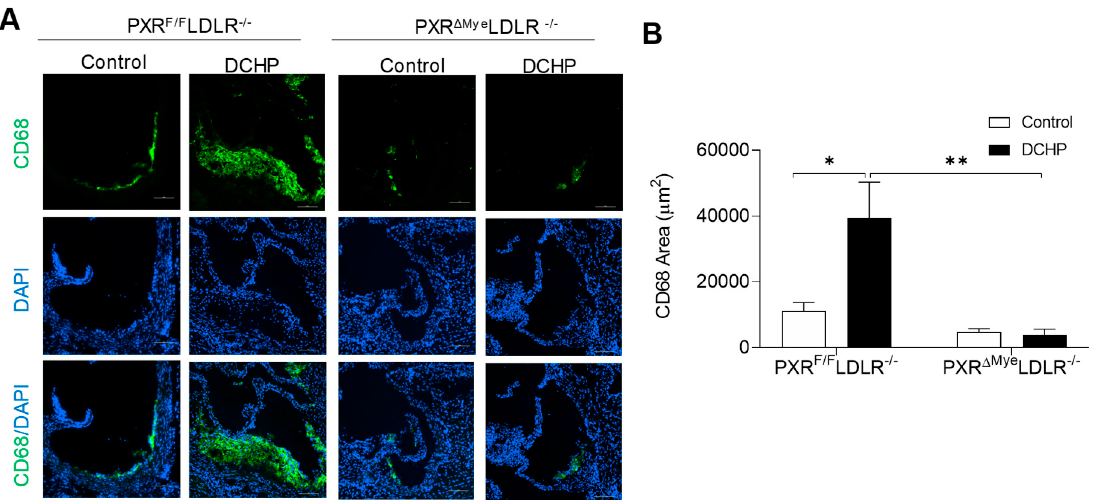
Figure 5. Exposure to DCHP increases atherosclerotic lesional macrophage content in PXR F/F LDLR − / − but not PXR ∆ Mye LDLR − / − mice. Four-week-old male PXR F/F LDLR − / − and PXR ∆ Mye LDLR − / − littermates were fed a low-fat diet and treated by oral gavage with 10 mg/kg body weight of vehicle (corn oil) or DCHP daily for 12 weeks. ( A ) Representative images of immunofluorescence staining of CD68 (Green) in the aortic root of PXR F/F LDLR − / − and PXR ∆ Mye LDLR − / − mice (Scale bar = 100 μ m). The nuclei were stained with DAPI (Blue). ( B ) Quantification analysis of CD68 staining area in the aortic root of PXR F/F LDLR − / − and PXR ∆ Mye LDLR − / − mice. Data are represented as mean ± SEM (n = 5, * p < 0.05 and ** p < 0.01).